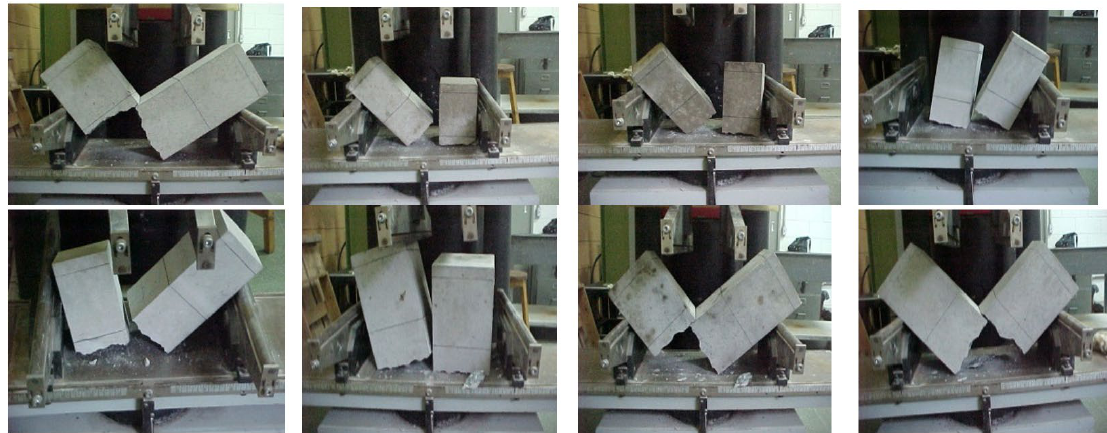
Figure 12. Fractured sections for the high strength concrete during fatigue tests.